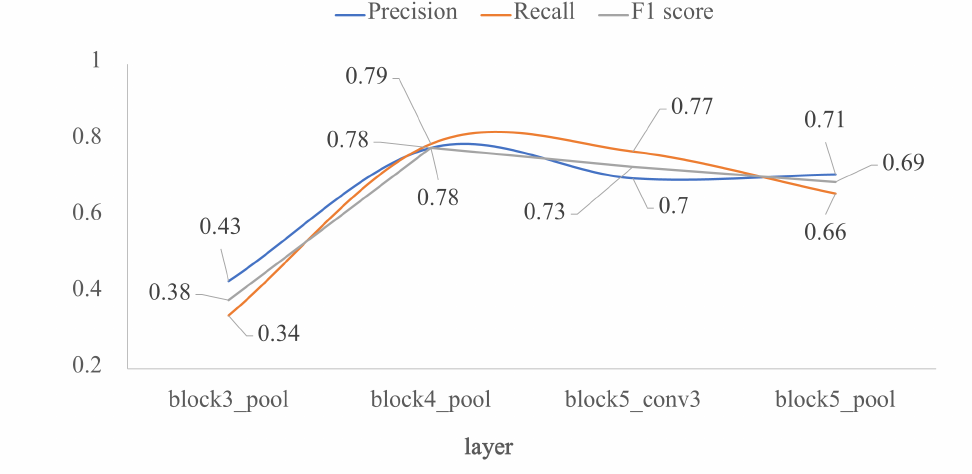
Figure 7. Impact of the depth for the architecture by transfer learning using VGG-16, in terms of P , R and F1 : external test. The x -axis corresponds to the selected last layer of VGG-16, and the y -axis are the evaluated metrics.